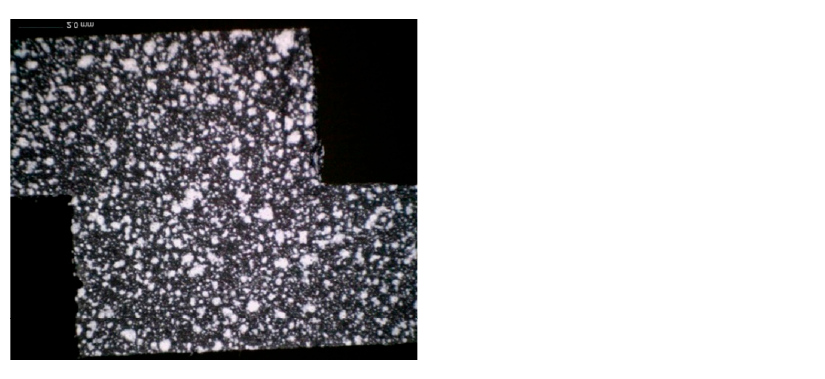
( d ) N = 209,000 Figure 5. Example of shear strain values measured by digital image correlation during a test: ( a ) at the beginning of the test; ( b ) last acquisition before crack onset; ( c ) first acquisition after crack on- set; ( d ) a few cycles before the final failure. 2.5. Statistical Analysis In order to assess if the differences among series of data belonging to distinct families of specimens were significant, the results underwent statistical analysis. Specifically, an analysis of variance (ANOVA) was carried out with the intent to check if the data disper- sion was such to produce a distribution of the results around the same average value, regardless of the applied pretreatment. In particular, the application of a two-factors and two-levels ANOVA design allowed to separately consider first the influence of the em- ployed treatments and then the effect of every process parameter, limited to plasma treat- ments. Therefore, the two factors represented by the treatments (factor A = abrasion, factor B = APPT with D = 5 mm and v = 100 mm/s) and the two levels describing the occurrence of the specific treatment (level 1 = yes, level 2 = no) were able to allow the evaluation of the statistical weight covered by abrasion only, by plasma treatment only and by the com- bined use of them in determining any differences in the averages, while the second ANOVA took into account all and only the APPT joints, used D and v as factors and the